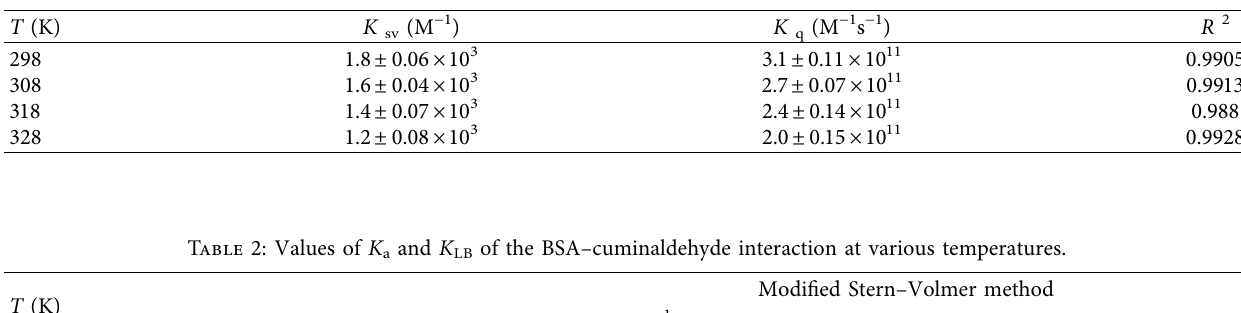
Figure 3: (a) Stern–Volmer plots, (b) modifed Stern–Volmer plots, and (c) plots of log ( F 0 – F )/ F vs. log {[D] 0 - n [ P ] 0 ( F 0 - F )/ F 0 } of interaction of BSA with cuminaldehyde at four diferent temperatures. Te concentration of BSA was kept constant at 3 μ M while concentration of cuminaldehyde was varied from 0-200 at a constant increment of 20 μ M. Te medium of the study was 20mM tris bufer of pH 7.4. Table 1: Values of K SV and K q of the BSA–cuminaldehyde interaction at various temperatures.